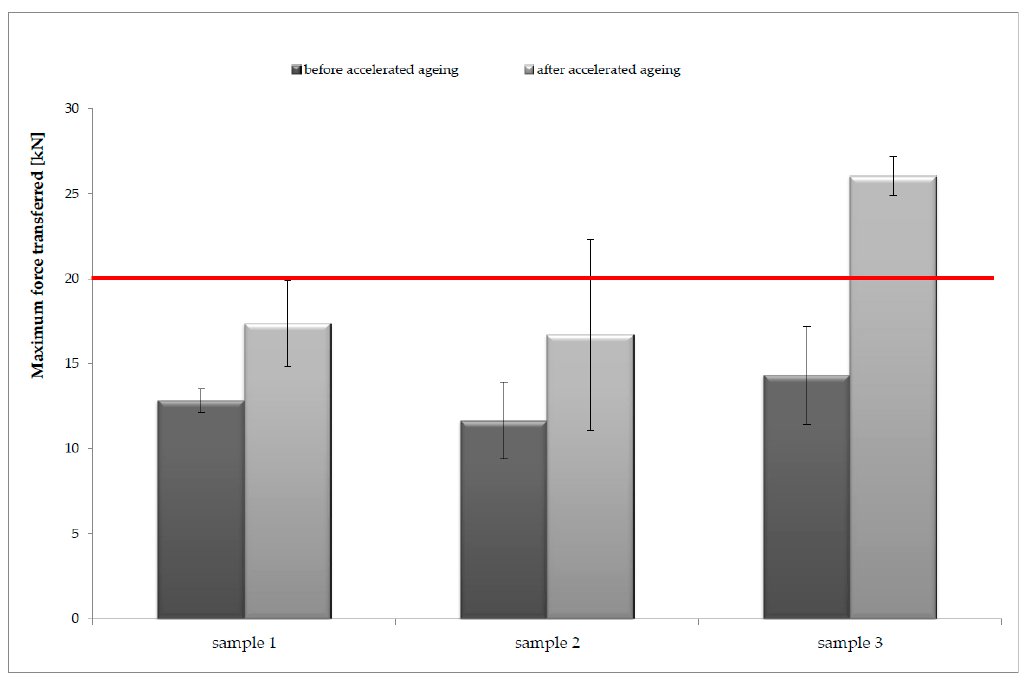
Figure 7. Dependence between the maximum force transmitted under the tested samples and the type of sample used for the tests, executed before and after the process of accelerated aging; the red line is the limit of the general mean value of force transferred for level 2